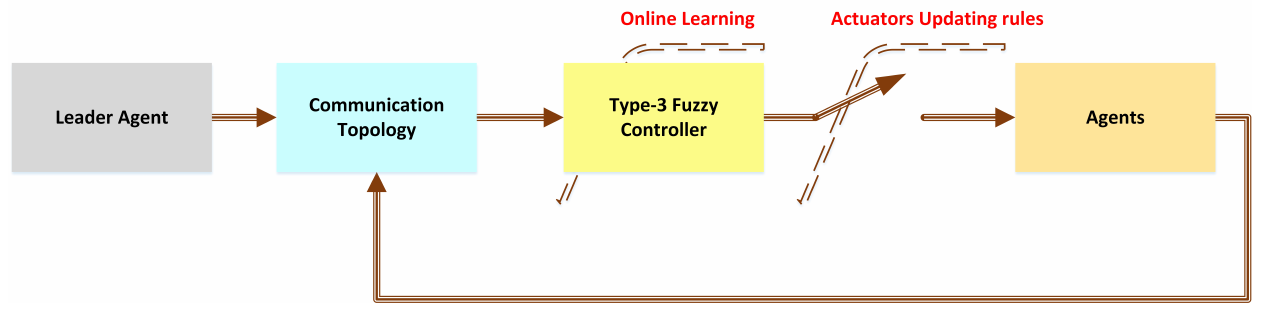
Figure 1. The general scheme for suggested controller.